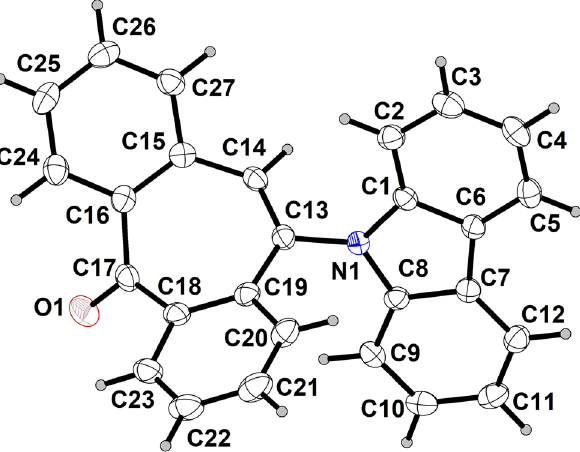
Table  : Data collection and handling.